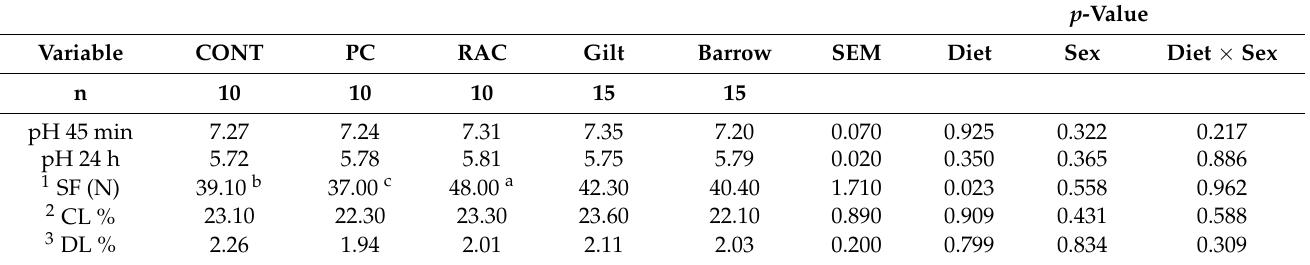
Table 4. Effect of different treatments on meat quality (Longissimus dorsi) 24 h after slaughter.